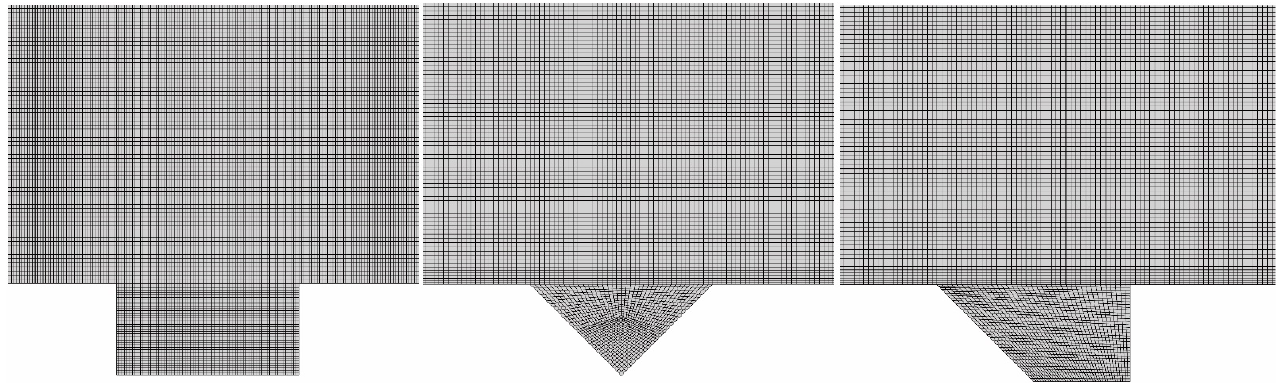
Figure 3. The structured mesh used in the numerical simulations for three types of grooves.